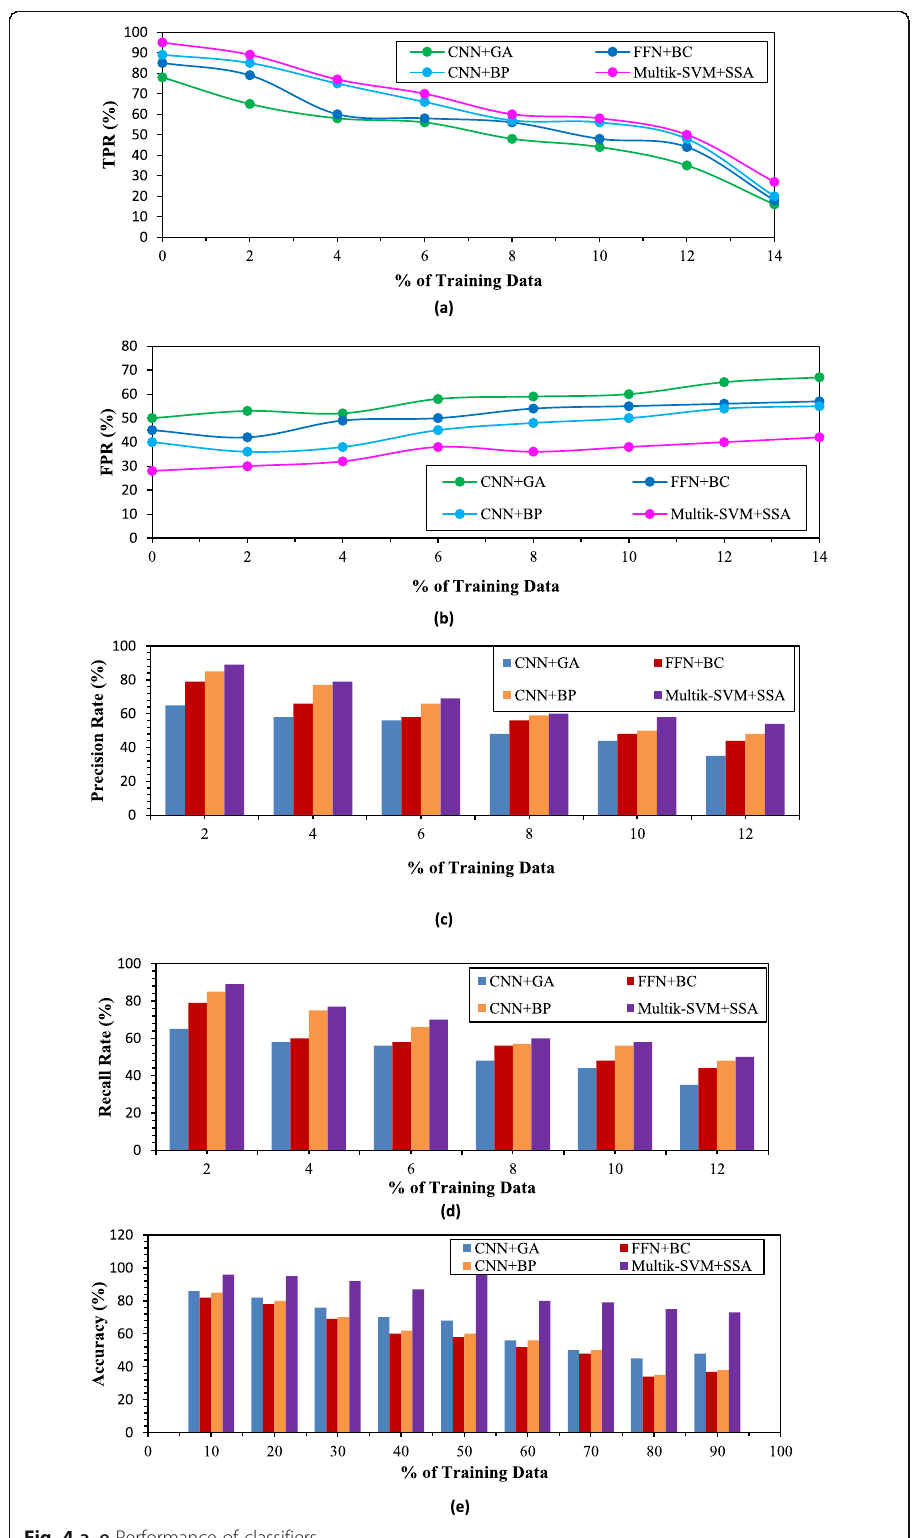
Fig. 4 a – e Performance of